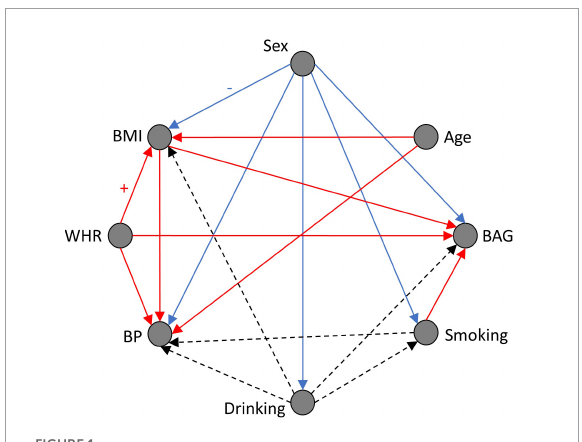
FIGURE1 Bayesian network structure (directed acyclic graph), and conditional probability distribution visualization. Red edge: positive association. Blue edge: negative association. Dashed edge: non-linear association. Sex: Male = 0, Female = 1; BAG, brain age gap; BMI, body mass index; BP, blood pressure; WHR, waist-to-hip